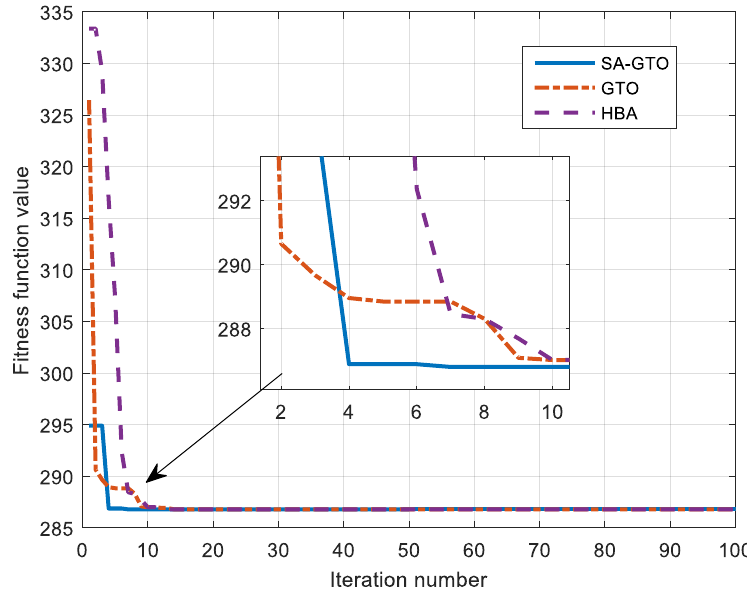
Figure 14. Fitness function versus iteration number curve. Table 8. Comparison of statistical measures of different